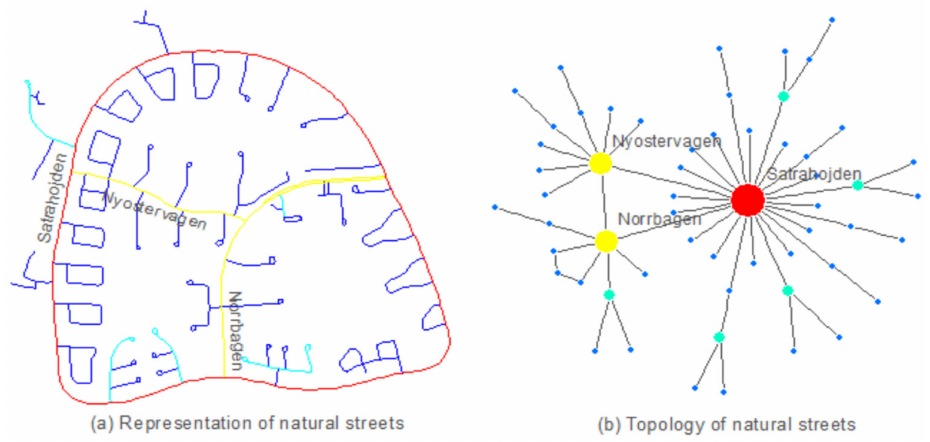
Figure 5. (Color online) A living structure with four hierarchical levels of natural streets. (Note: The natural streets that are represented—on the surface—by geometrical details of locations, sizes, and directions ( a ) are transformed into the topology of the streets or living structure, in the deep sense, with far more less-connected streets than well-connected ones ( b